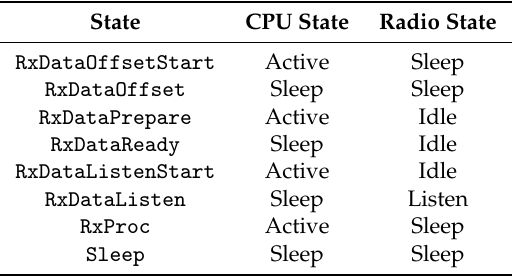
Table 5. States in a RxIdle slot.